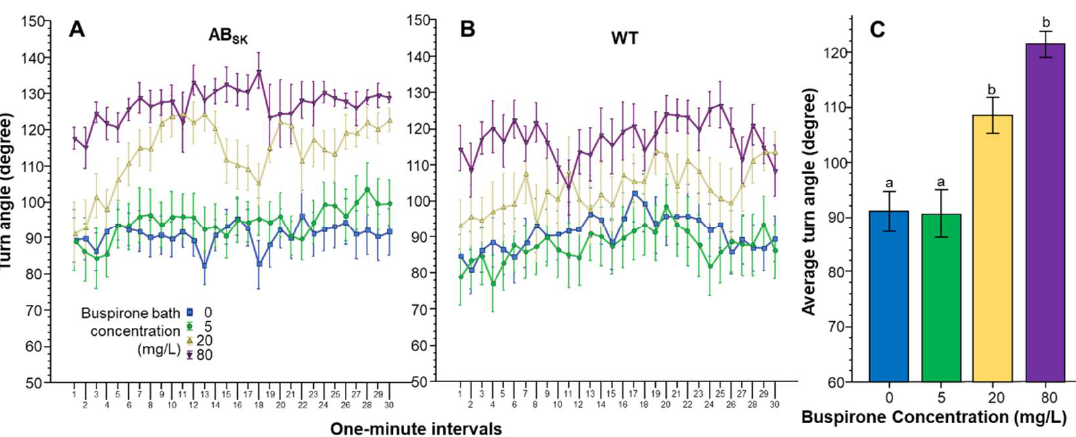
Figure 4. Turn angle is dose dependently increased by buspirone. Turn angle as a function of time (1-min intervals) is shown for ABSK panel ( A ) and WT panel ( B ) zebrafish. The legends show the buspirone concentrations employed (blue line with rectangle 0 mg/L, green line with circle 5 mg/L, yellow line with triangle 20 mg/L, and purple line with upside down triangle 80 mg/L). Panel ( C ) shows the average turn angle calculated for the entire 30 min recording session, pooled for the two populations, exhibited by the zebrafish exposed to the different concentrations of buspirone (indicated underneath the X axis and also by the same color coding as in panels ( A , B )). Means + S.E.M. are shown. The results of Tukey HSD test are shown as letters above each bar of the bar graph Panel ( C ). Bars that do not share one letter in common represent buspirone treatment groups that are significantly ( p < 0.05) different from each other. For detailed results of statistical analyses, see Results.